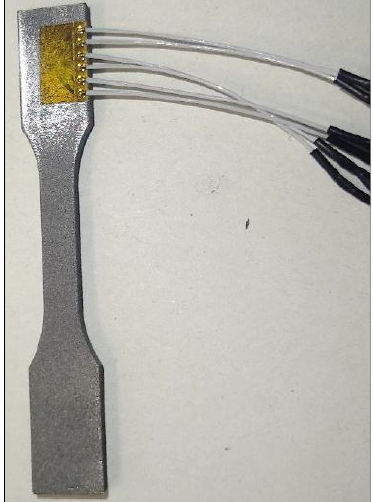
Figure 2. Strain gage method in hole drilling for measurement of residual